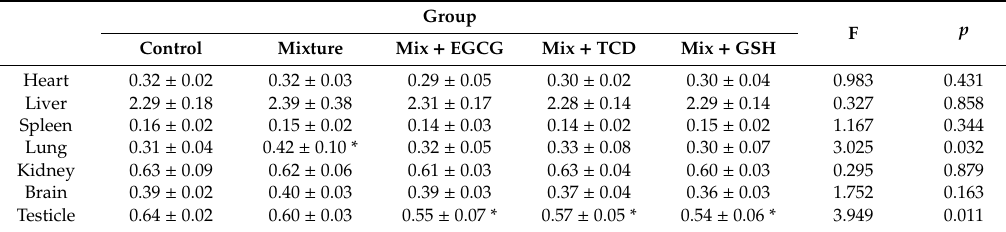
Table 3. E ff ects of the heavy metal mixture on the organ / body weight coe ffi cients with or without the addition of chemical antagonists in SD rats ( n =